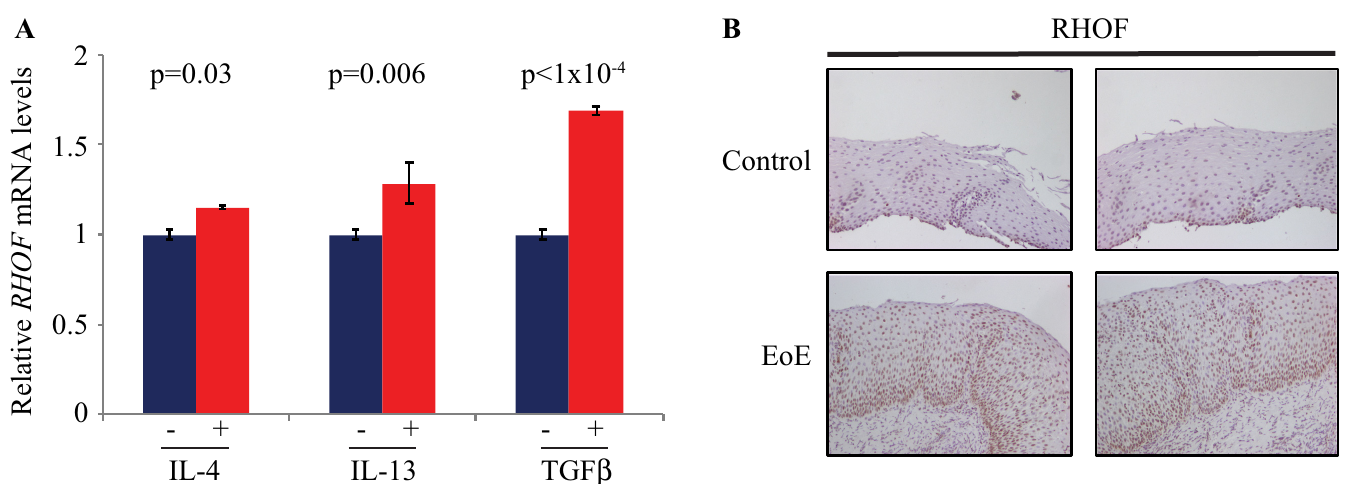
Fig 5. RHOF is upregulated in human EoE. ( A ) Primary human esophageal epithelial cells stimulated with IL-4, IL-13, or TGF- β , cytokines that are physiologically relevant for human EoE, had significant increases in RHOF expression by qPCR, compared to unstimulated cells. ( B ) By immunohistochemistry, RHOF levels increased dramatically in EoE compared to normal esophageal